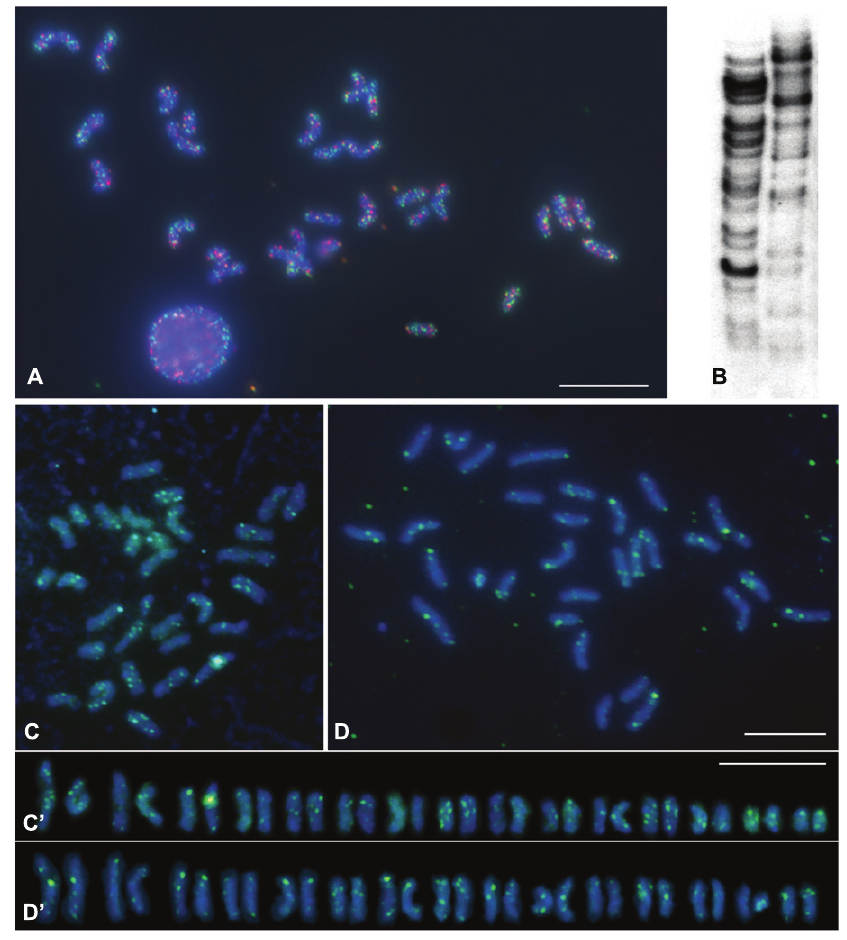
Fig. 3, A-D’. FISH in H. magnipapillata mitotic chromosomes with two BAC probes. Numerous signals are visible in every chromosome ( A ). Southern blot of DNA sample of H. magnipapillata digested with HindIII (left lane) and EcoRI (right lane) hybridized with Tol2 transposable element probe ( B ). FISH in H. magnipapillata mi- totic chromosomes with Tol2 transposable element probe. Signals are visible in every chromosome( C - D ). Mitotic plates ( C , D ) and karyograms ( C’ , D’ ) from different FISH experiments. Chromosomes are counterstained blue with DAPI. Bars = 10